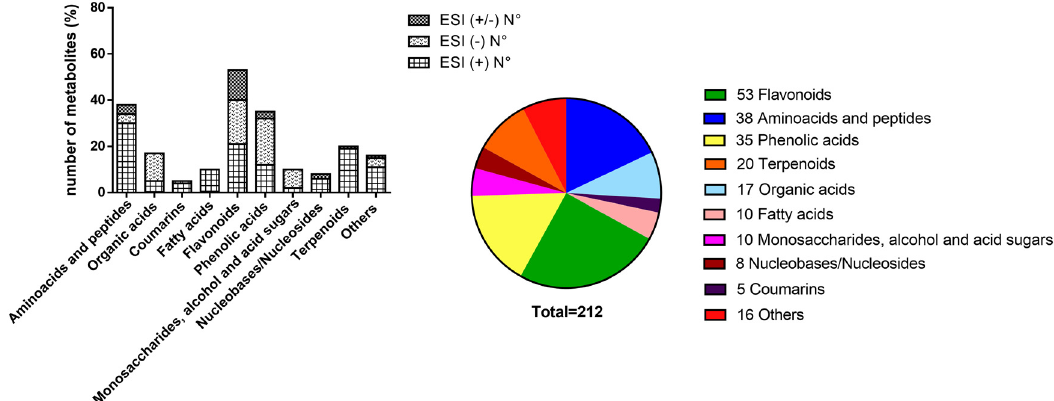
Figure 1. Metabolites in the fermented aqueous extracts of V. album putatively annotated by LC-HRMS / MS according to the ionization mode and chemical